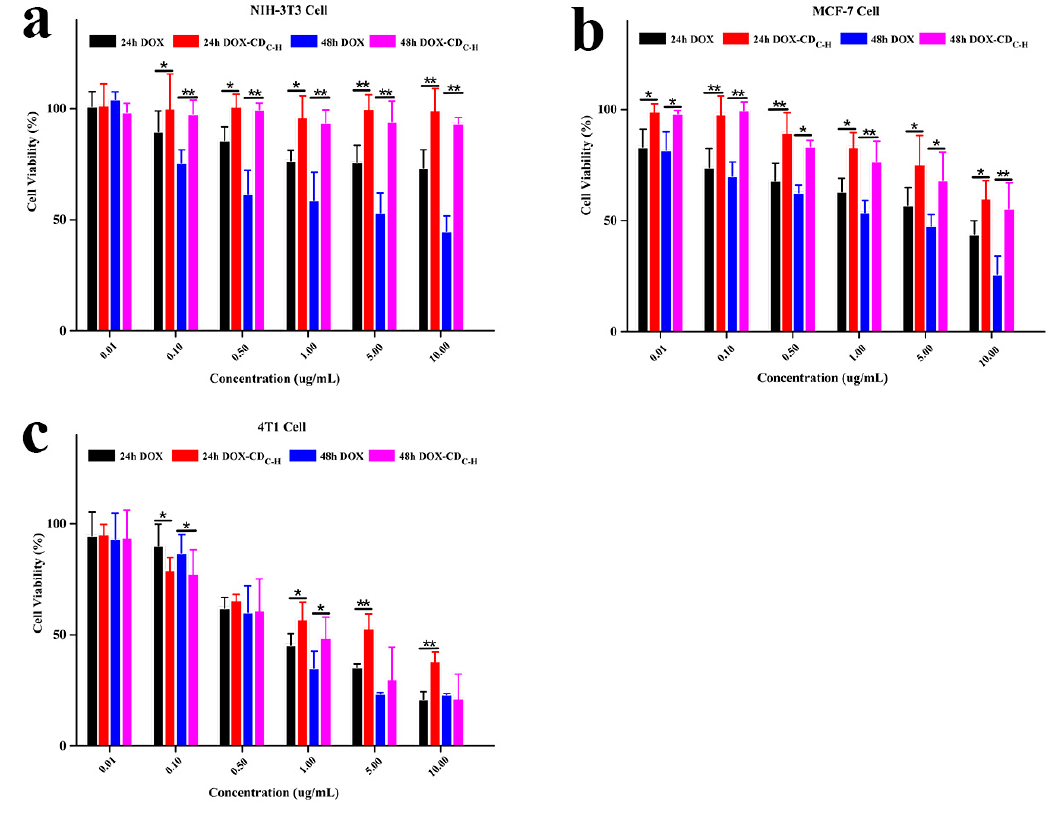
Figure 6. Cytotoxicity results of free DOX and DOX–CD C-H complexes to NIH-3T3, MCF-7 and 4T1 cells ( a – c ) at different times. Data represent mean ± SD, n = 3; * p < 0.05 and ** p < 0.01, vs. free DOX.